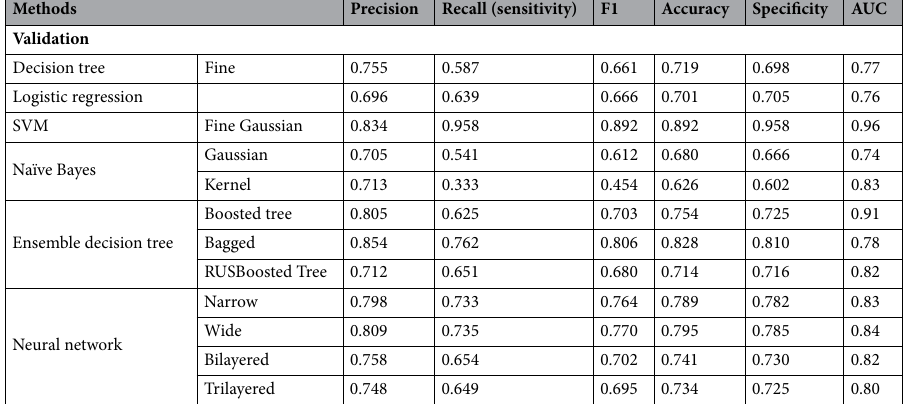
Table 3. Performance parameters of trained model on validation for prediction of VTDR at 10-year. VTDR vision-threatening diabetic retinopathy, AUC area under curve of receiver operating characteristics, SVM support vector machine.